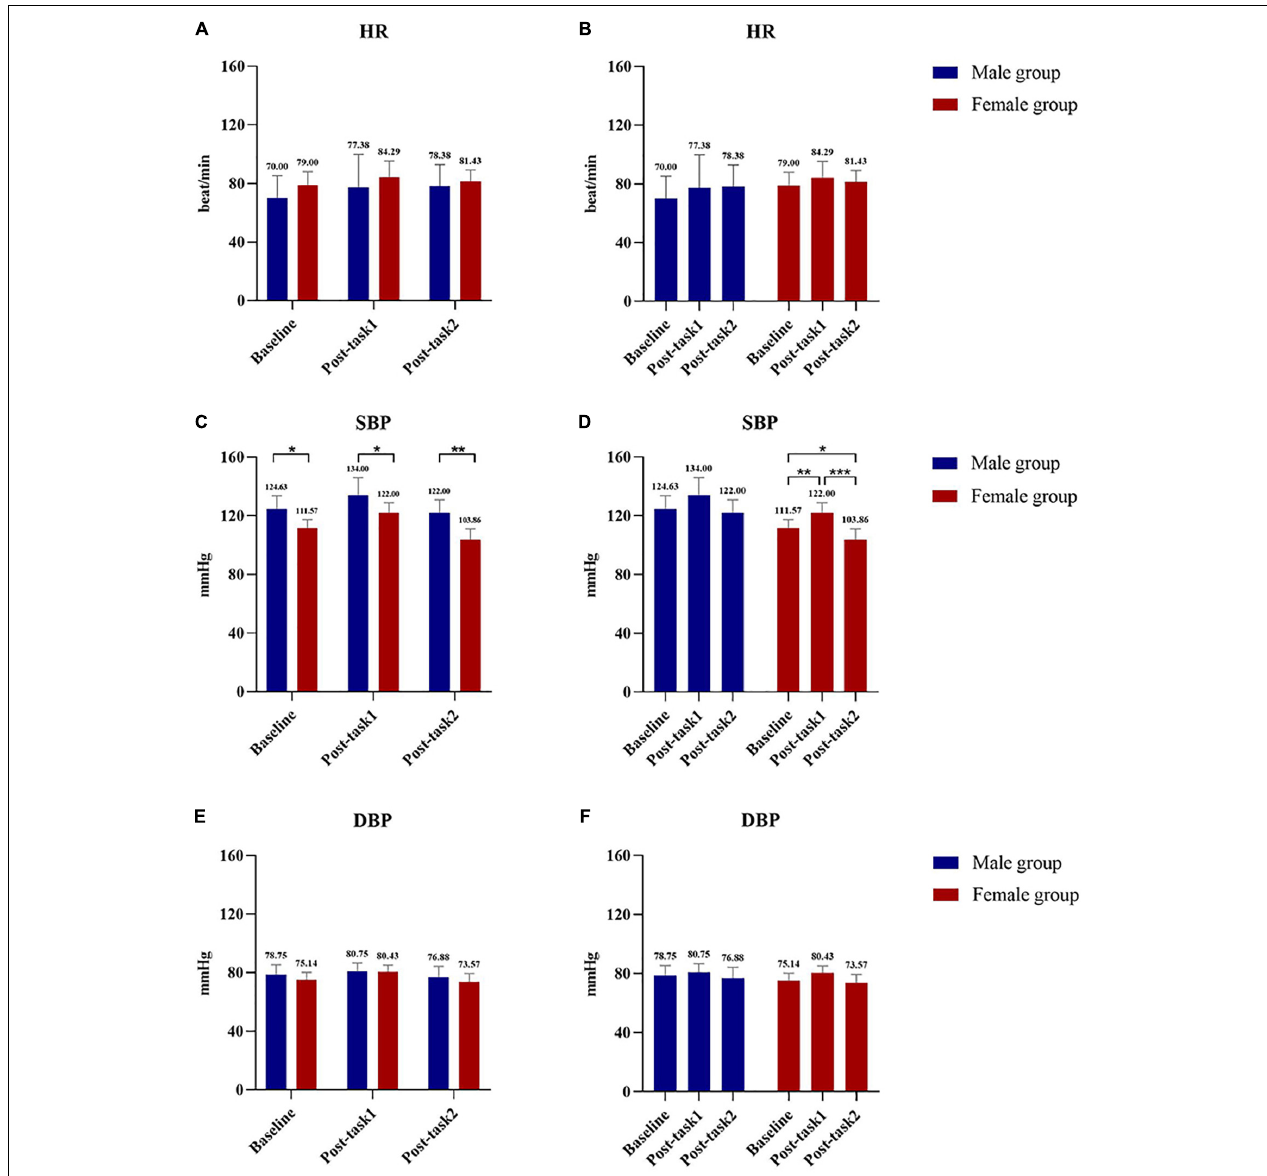
FIGURE 4 | Comparison of HR, SBP and DBP between male group and female group at 3 time points between groups and within groups. (A) Comparison of HR at Baseline, Post-task 1 and Post-task 2 between male and female group. (B) Comparison of HR at Baseline, Post-task 1 and Post-task 2 in male group and female group. (C) Comparison of SBP at Baseline, Post-task 1 and Post-task 2 between male and female group. (D) Comparison of SBP at Baseline, Post-task 1 and Post-task 2 in male group and female group. (E) Comparison of DBP at Baseline, Post-task 1 and Post-task 2 between male and female group. (F) Comparison of DBP at Baseline, Post-task 1 and Post-task 2 in male group and female group. Post-task 1: after the NIVR-Exergame task; Post-task 2: after the resistance band stretching task. mmHg, millimeters of mercury; min, minute; HR, heart rate; SBP, systolic blood pressure; DBP, diastolic blood